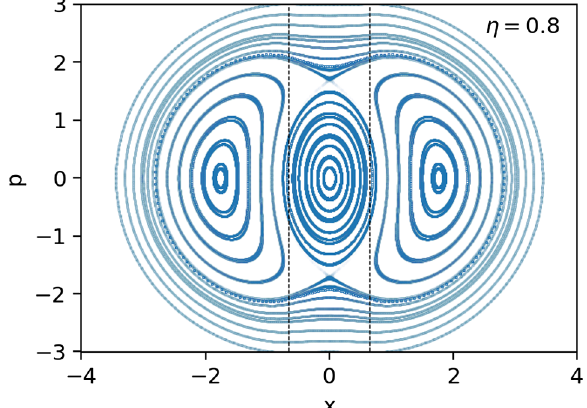
FIG. 6. Stroboscopic plot of particles at every minimum of the envelope which is indicated by the black dashed line. The